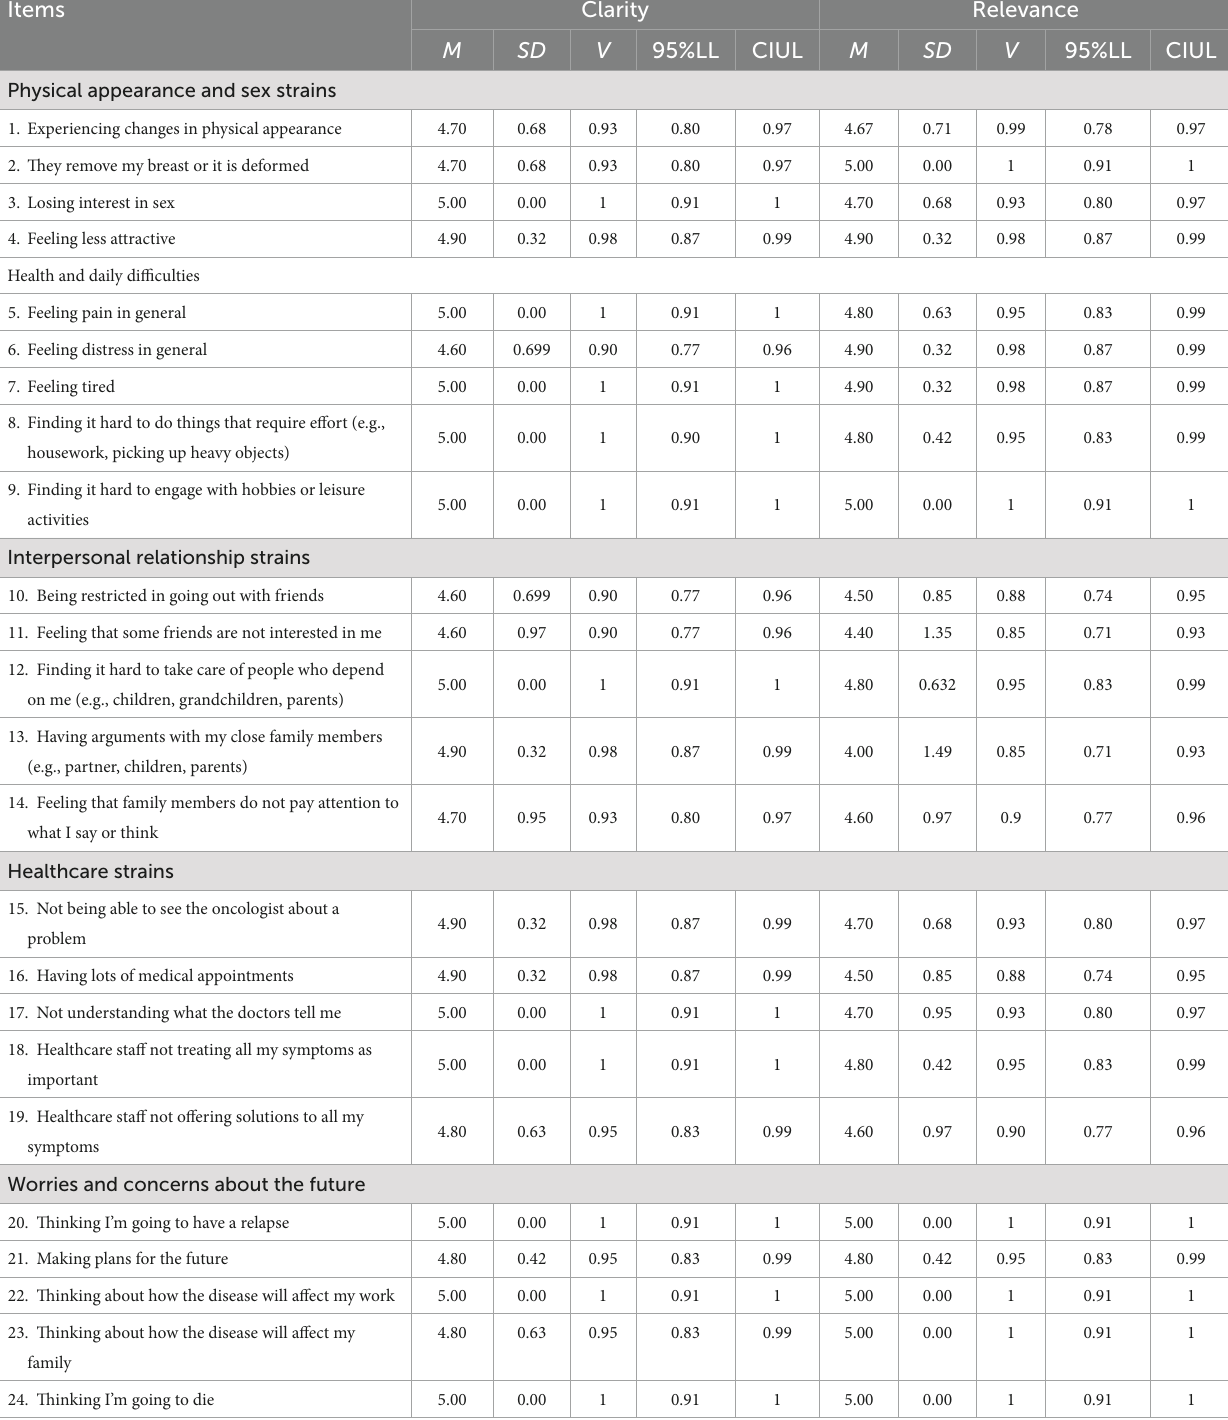
TABLE 1 Means for clarity and relevance, and values of the V index and its 95% confidence interval.